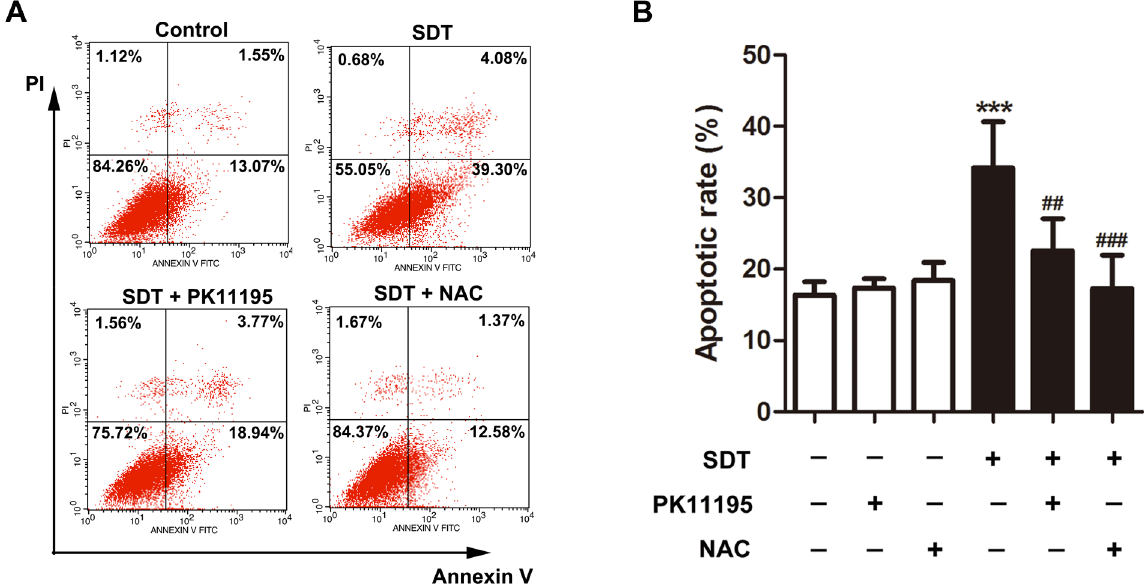
Fig 6. Effects of PK 11195 and NAC on SDT-induced macrophage apoptosis. THP-1 macrophages were treated for 3 hours with 5-aminolevulinic acid mediated sonodynamic therapy (ALA-SDT), with or without pretreatment of PK 11195 and NAC. Cell apoptosis and necrosis were assessed by flow cytometry with double staining of Annexin V and propidium iodide (PI). (A) Cells in the lower-right quadrant (Annexin-V + /PI - ) represent early apoptotic cells. (B) Quantifications of early apoptosis rate in the indicated groups. (cid:3)(cid:3)(cid:3) P < 0.001 compared to no treatment group, ## P < 0.01 compared to ALA-SDT treated group, ### P < 0.001 compared to ALA-SDT treated group.